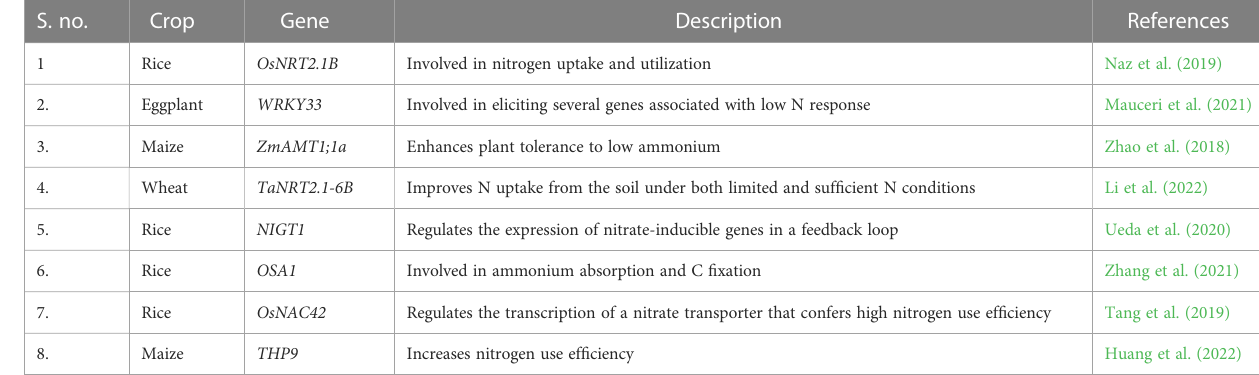
TABLE 5 Genes identi fi ed in various crops related to